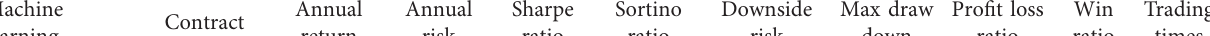
Table 15: Option strategy of predicting the rise and fall of volatility by threshold (use 8 features M1, threshold � 0.7). Machine learning